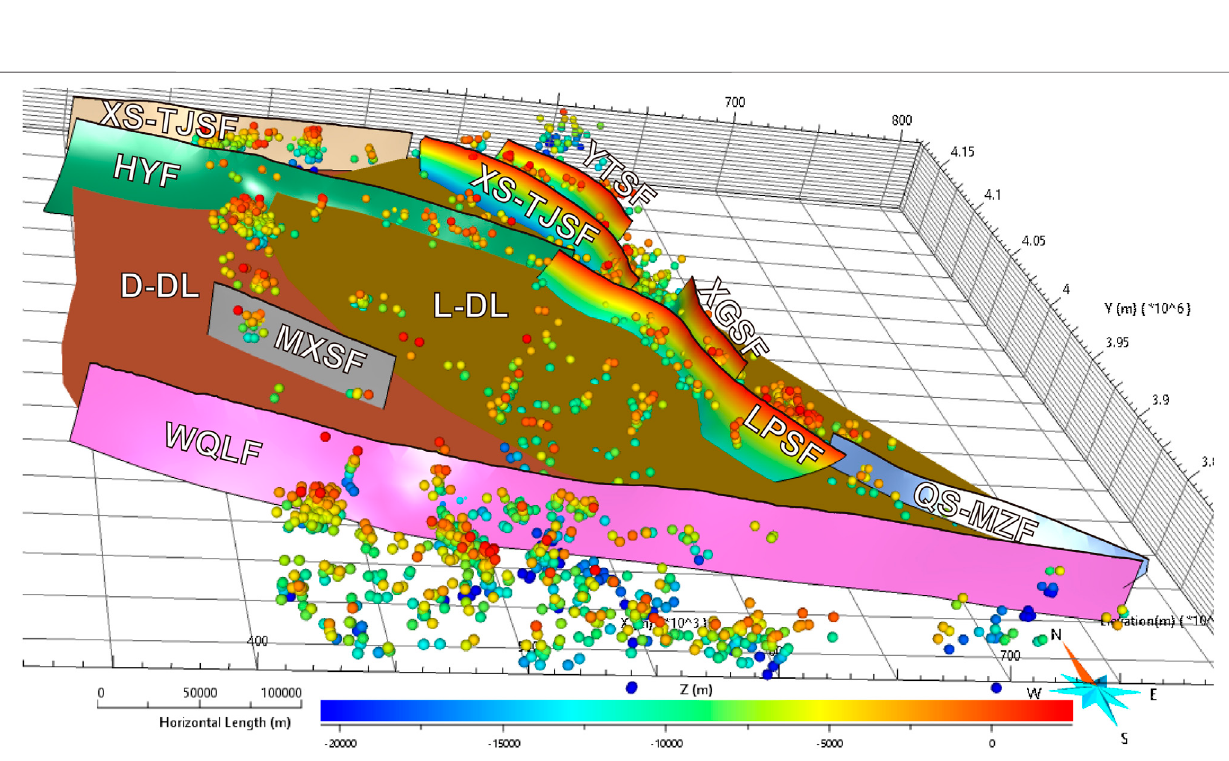
Frontiers in Earth Science |